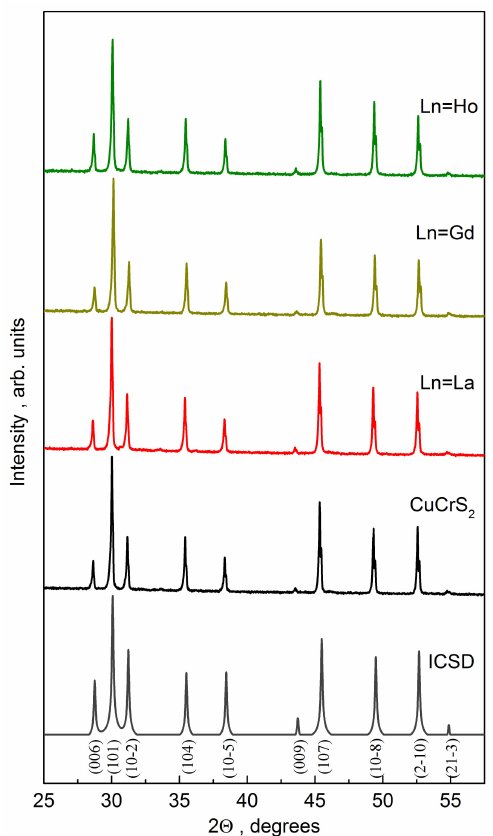
Figure 1. Powder diffraction patterns of CuCrS 2 -matrix and CuCr 0.99 Ln 0.01 S 2 solid solutions (Ln = La, Gd,